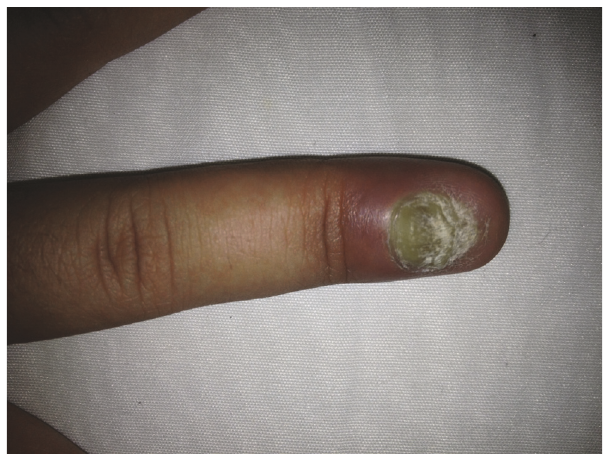
Figure 2: Improved nail psoriasis with onychomycosis and severe paronychia that persistedalthough the patient received nine months of canakinumab